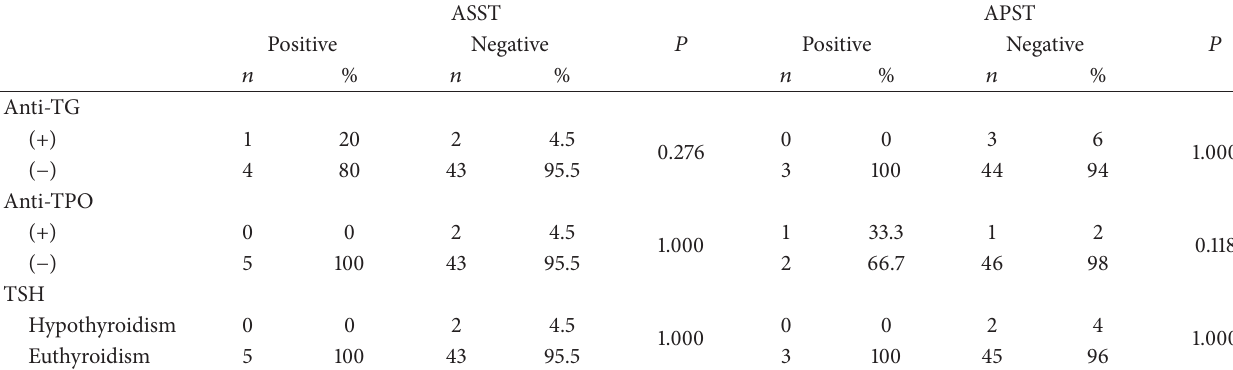
Table 6: The relationship between thyroid autoantibodies and ASST and APST results of the control group.